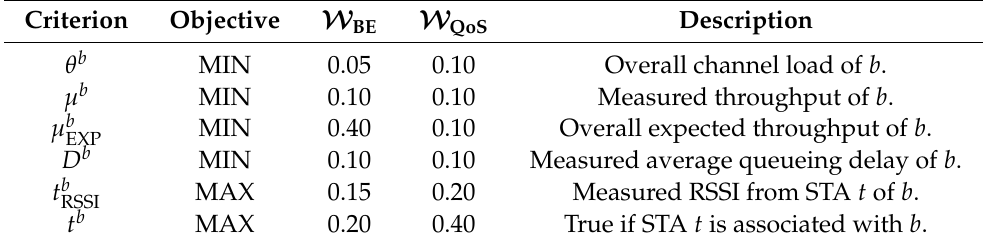
Table 4. Multi-Criteria Decision Analysis (MCDA) criteria, objectives, and weights for AP b .